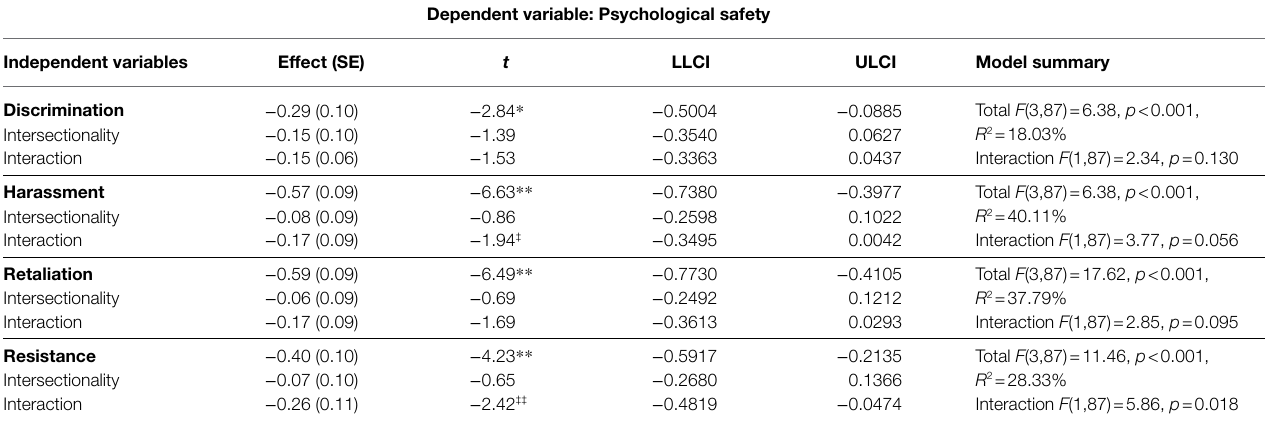
TABLE 2 | Moderation of the association between resistance-related experiences and psychological safety by intersectionality.